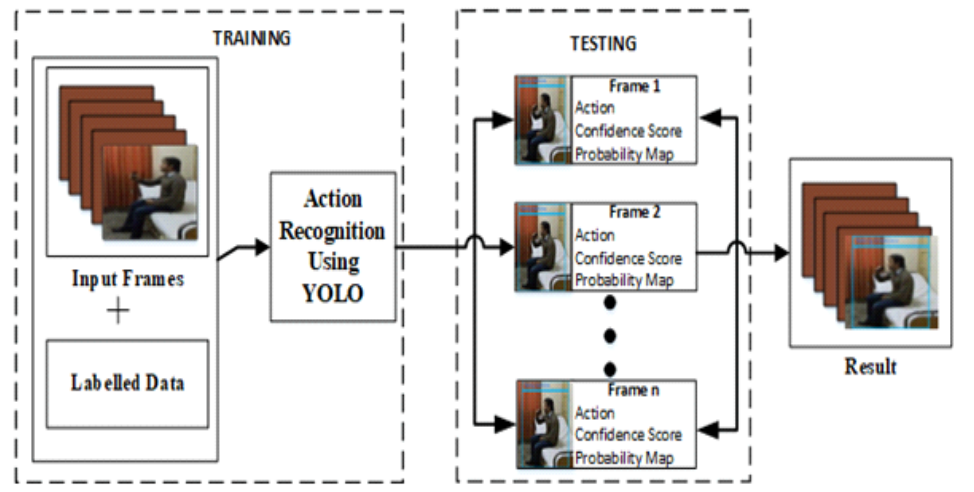
Figure 3. The representation of the entire proposed pipeline of our approach. It is divided into two main phases: training and